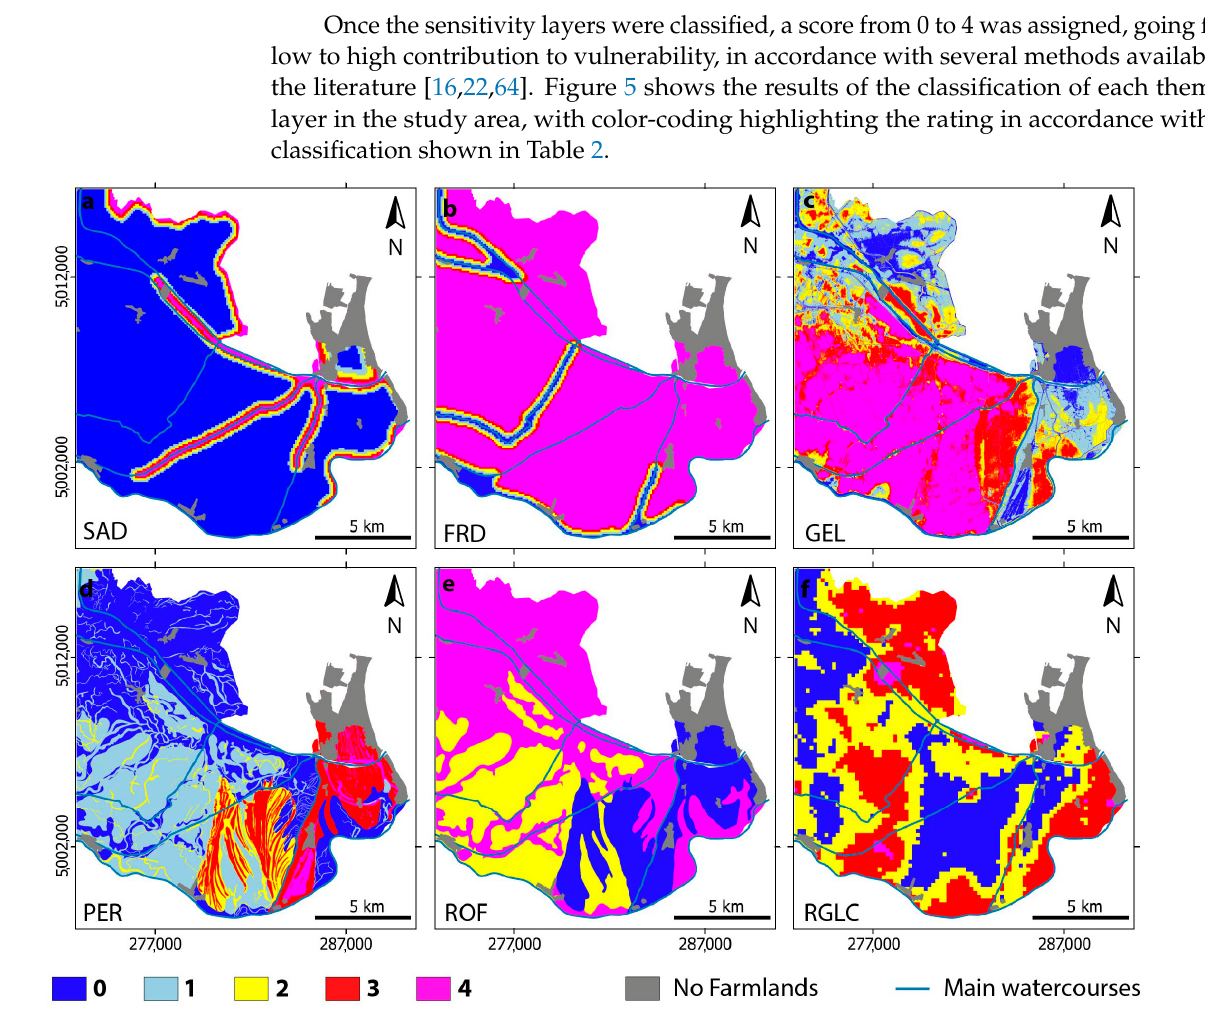
Figure 5. Classification of the sensitivity layers: ( a ) saltwater distance (SAD), ( b ) freshwater distance (FRD), ( c ) ground elevation level (GEL), ( d ) permeability (PER), ( e ) potential runoff (ROF), and ( f ) relative ground-level change (RGLC). Scores from 0 to 4 identify low-to-high contributions to vulnerability. Note that PER layer combines permeability and geomorphological